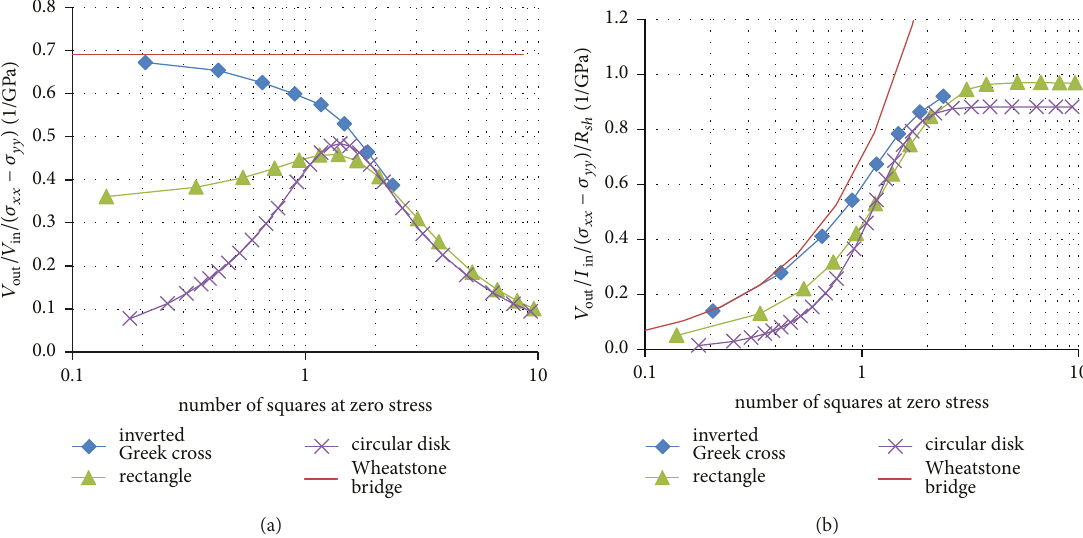
Figure 18: Comparison of (a) supply voltage related mechanical stress sensitivity, and (b) supply current related stress sensitivity of pseudo- Hall stress sensors with different shapes. Piezoresistive coefficient 𝜋 44 = 1.381/ GPa for low p-doped silicon was assumed. Only offset-free devices with 𝜆 𝑓0 = 𝜆 𝑝0 were considered. For the pseudo-Hall devices the number of squares is 𝑅 in /𝑅 sh = 1/𝜆 𝑓 +1/𝜆 𝑝 and for the Wheatstone bridge it is 𝑅 in /𝑅 sh = ℓ 𝑅 /𝑊 𝑅 .